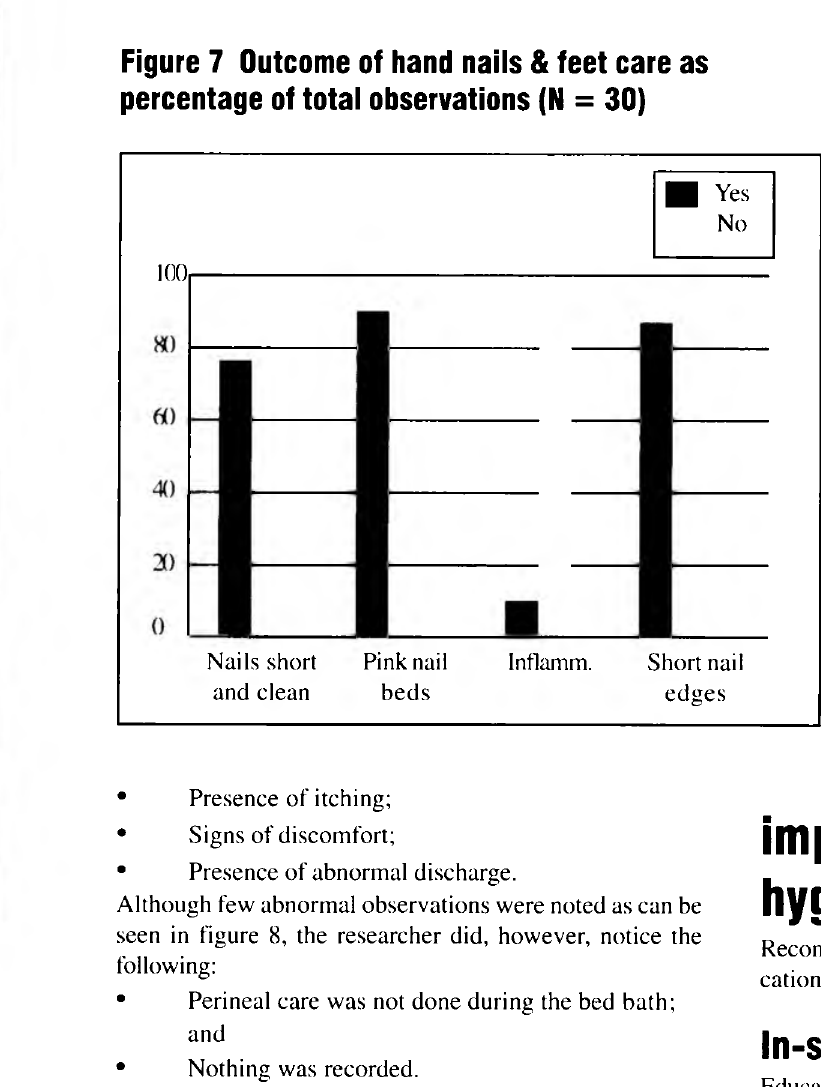
Figure 8 Outcome of perineal care as percentage of total observations (N =